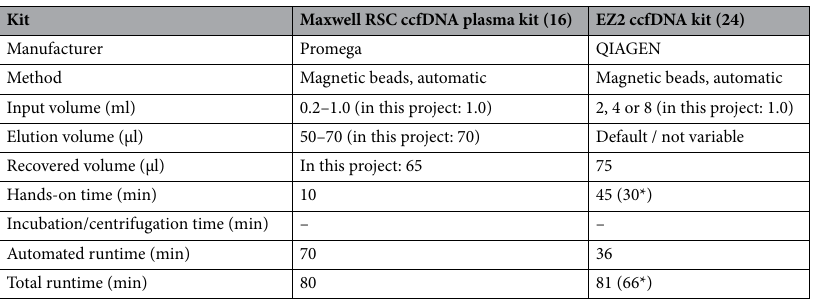
Table 2. Specifications of ccfDNA extraction kits used. * Calculated for 16